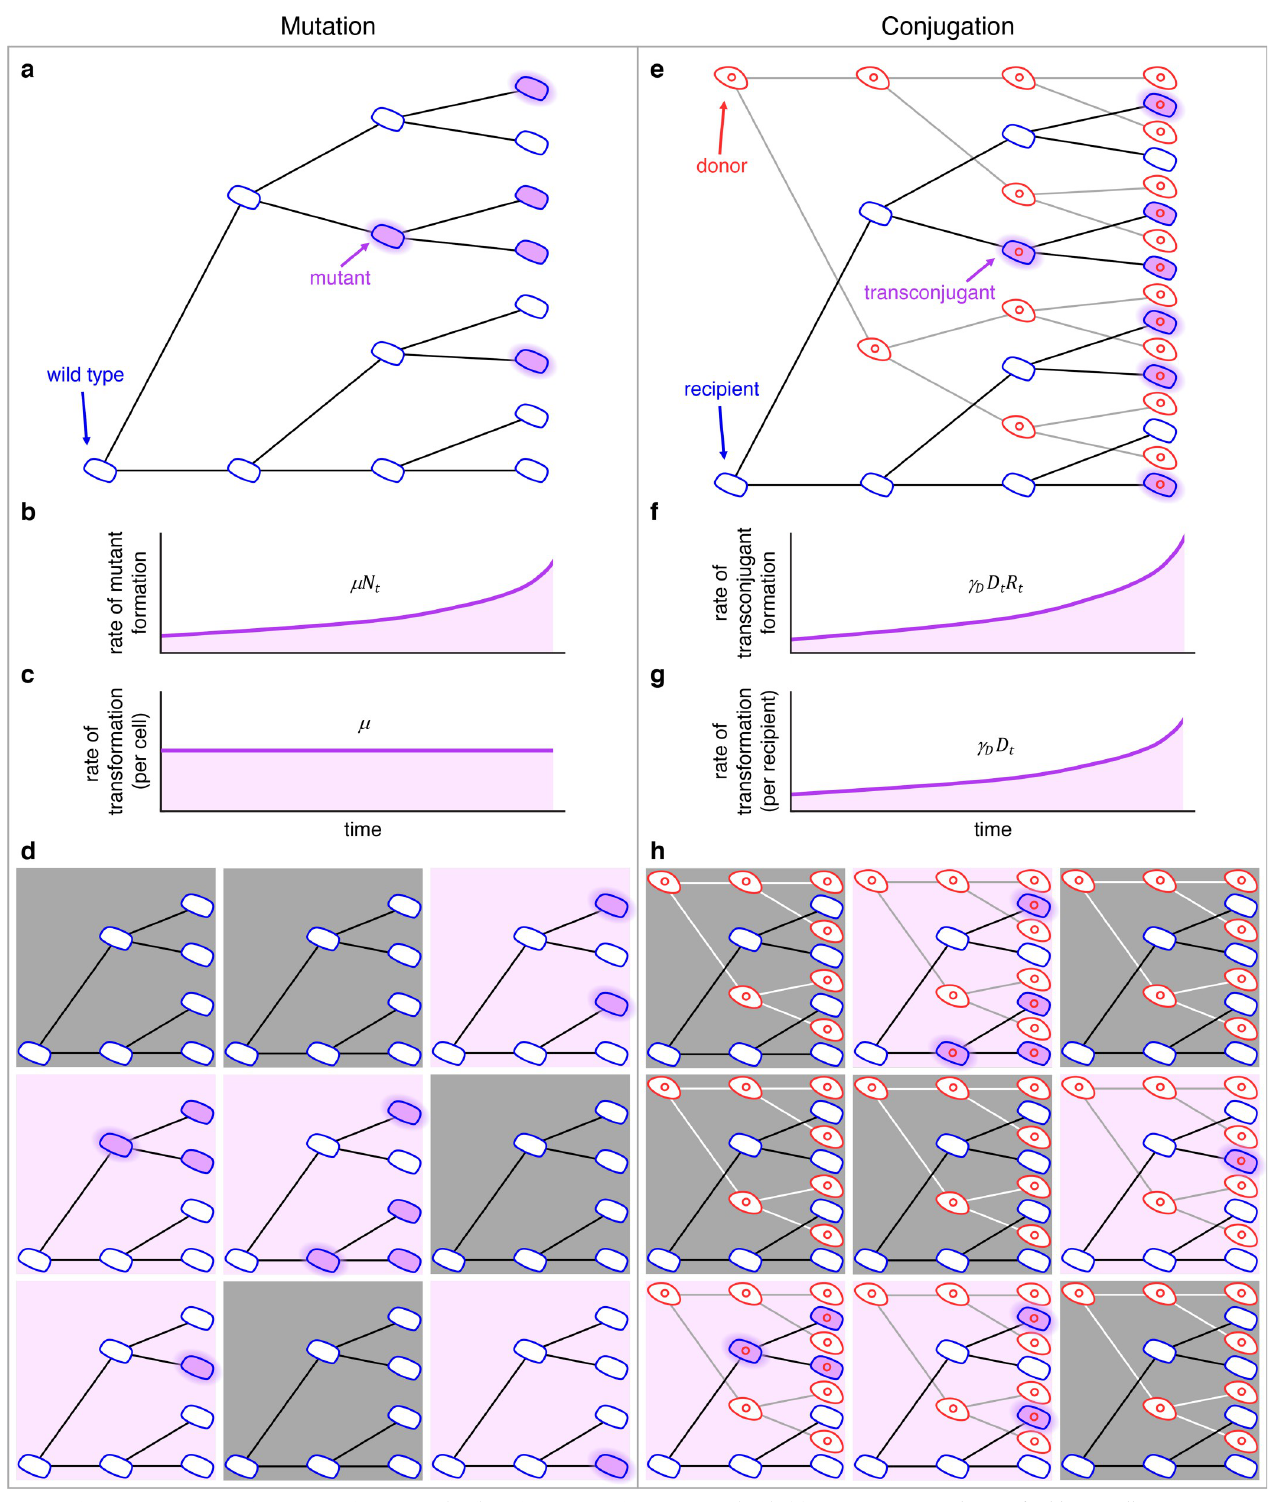
Fig 2. Schematic comparing the process of mutation (a–d) to the process of conjugation (e–h). (a) In a growing population of wild-type cells, mutants arise (highlighted purple cells) and reproduce (nonhighlighted purple cells). (b) The rate at which mutants are generated grows as the number of wild-type cells increases (i.e., μN t ). (c) The rate of transformation per wild-type cell is the mutation rate μ . (d) Wild-type cells growing in 9 separate populations where mutants arise in a portion of the populations (those with purple backgrounds) at different cell divisions. (e) In a growing population of donors and recipients,